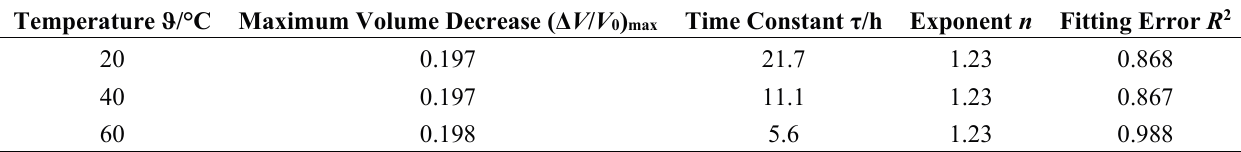
Table 1. Fitting parameters and fitting errors of the empirical equation for natural syneresis.